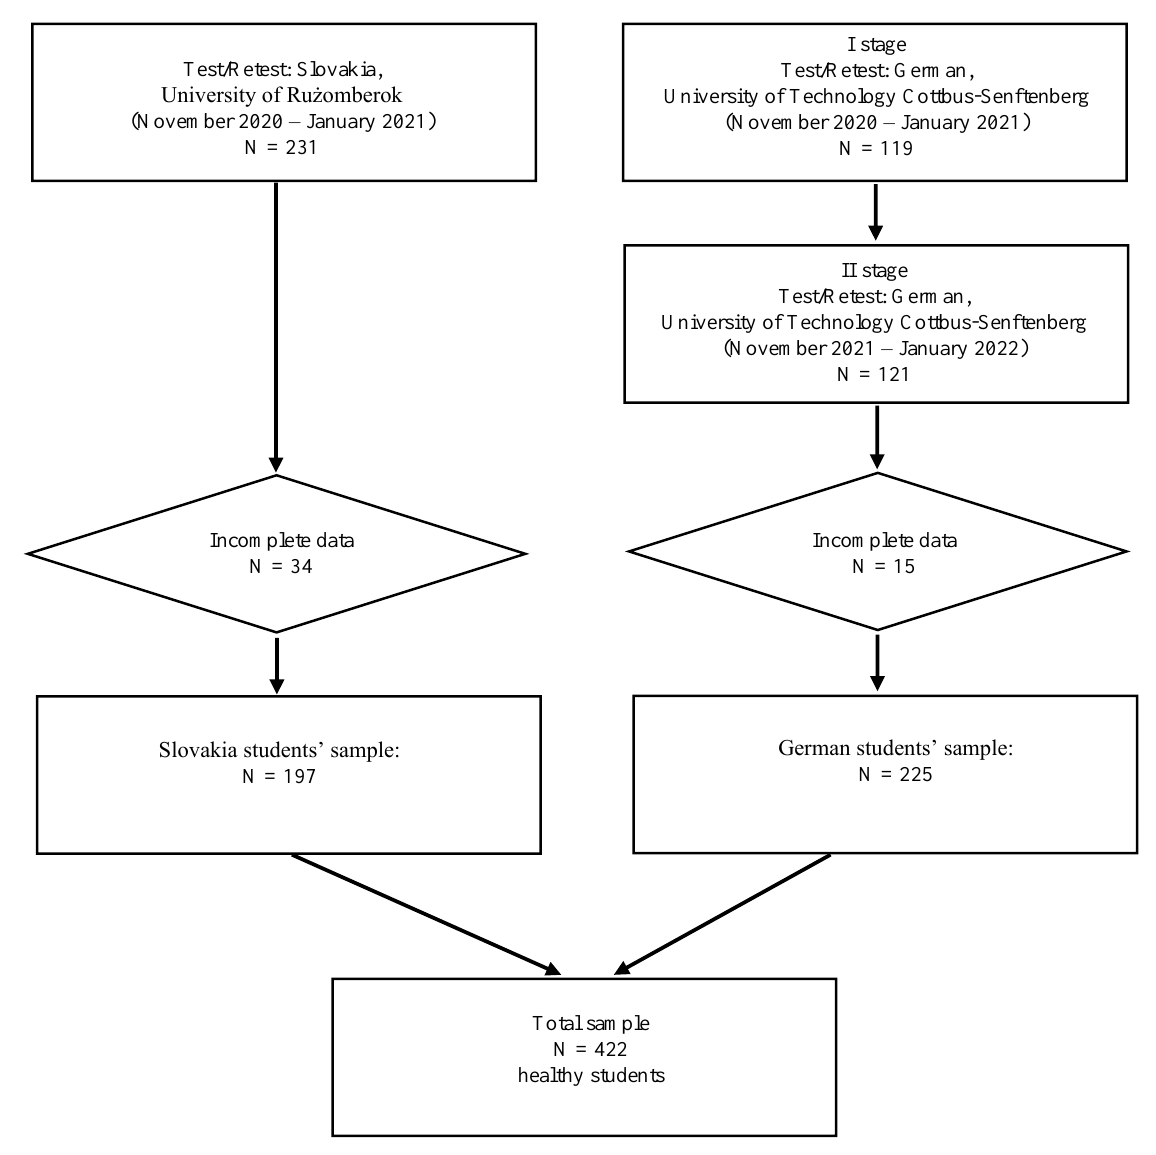
Figure 1. Study design and sample size.